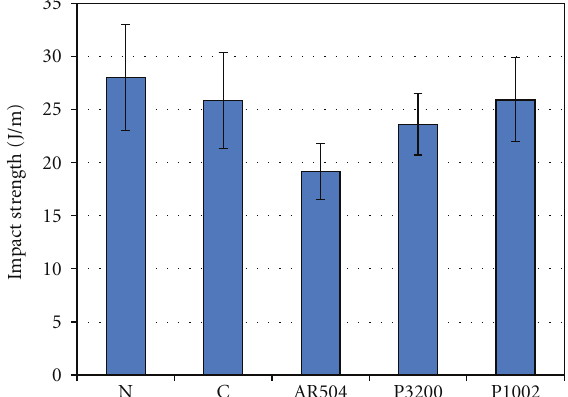
Figure 5: Comparison of absorbed impact energy for neat and sunflower hull-reinforced polypropylenes with and without the inclusion of chemical